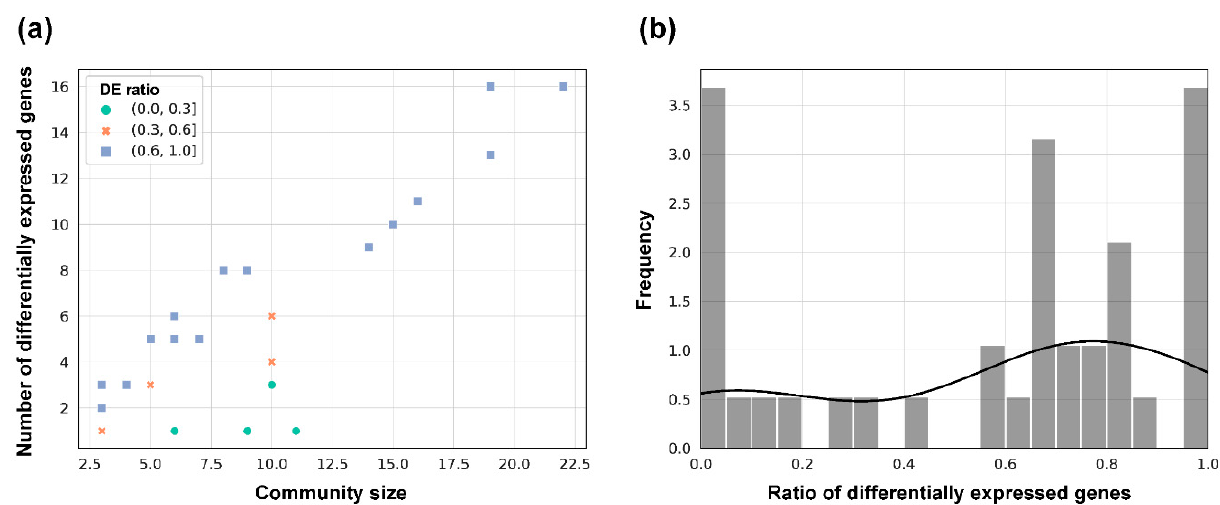
Figure 7. ( a ) Relationship between the community size and number of differentially expressed (DE) genes in that community (Supplemental Table S1B,C). ( b ) Histogram of the distribution of the proportions of differentially expressed genes (number of bins: 20. The ‘Frequency’ corresponds to the density estimated via the seaborn package).